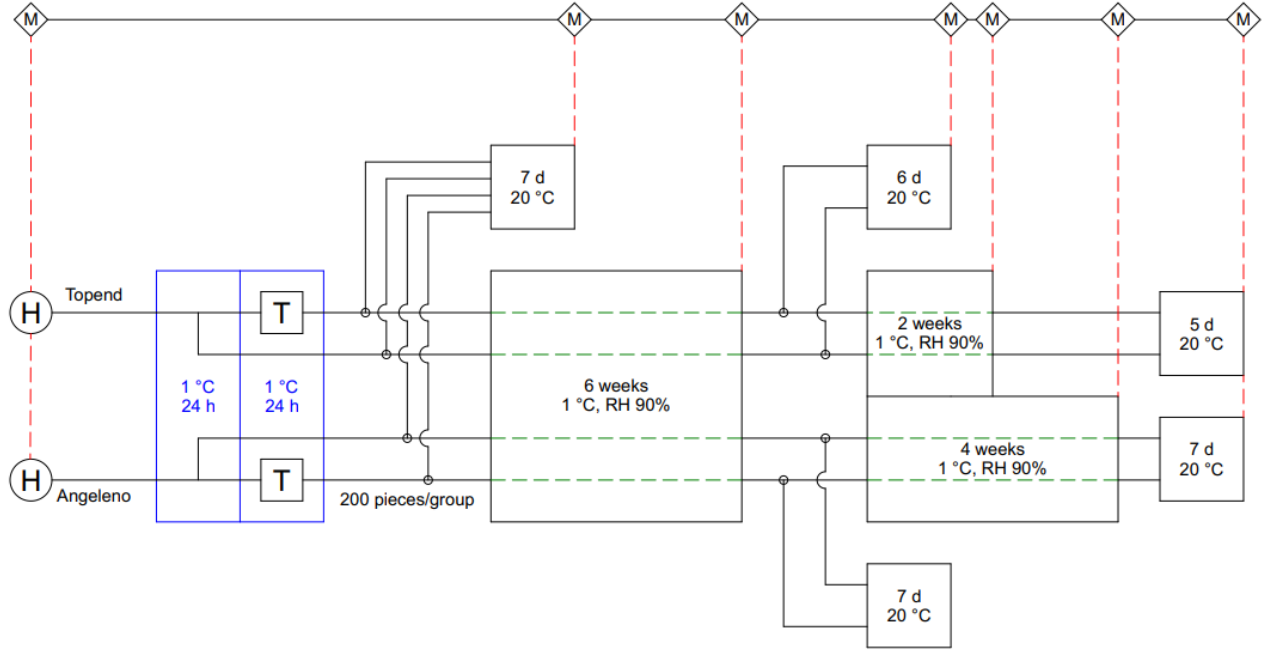
Figure 1. Figure 1. Flowchart of the experiment from harvest (H) with 1-MCP treatments [T] and measure- ments <M>.